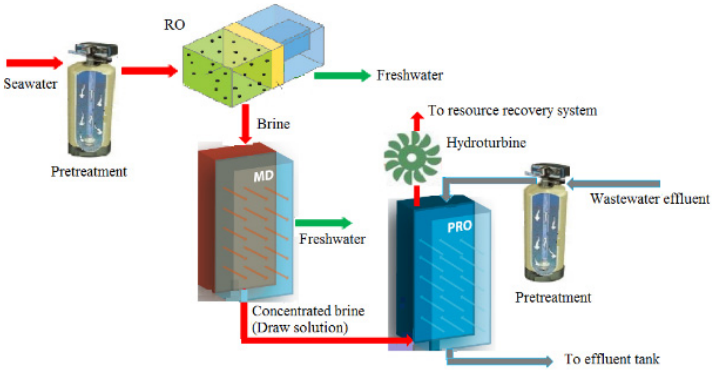
Figure 5. Schematic diagram of hybrid RO ‐ MD ‐ PRO in Korea implemented under Global MVP project.